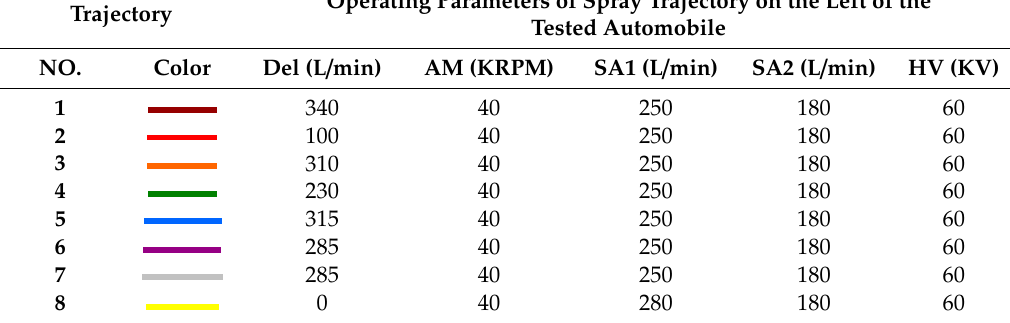
Table 3. Operating parameters of the spray painting trajectory on the right. Table 2. Operating parameters of the spray painting trajectory on the left. Table 2. Operating parameters of the spray painting trajectory on the left. Table 2. Operating parameters of the spray painting trajectory on the left. Table 2. Operating parameters of the spray painting trajectory on the left.